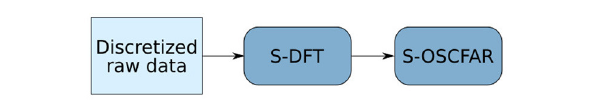
FIGURE 1 | Diagram of the implemented pipeline. The first block implements a spiking DFT on raw discretized FMCW radar data, and the second block implements the spiking